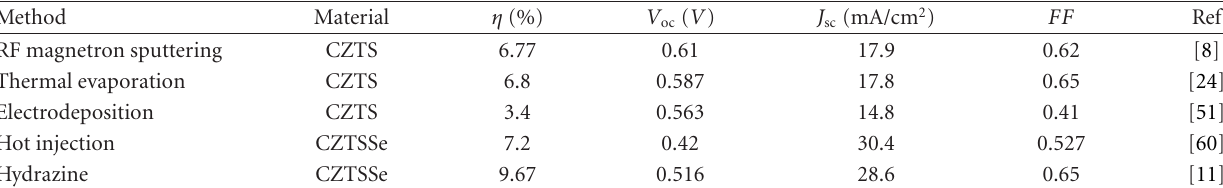
Table 1: Characteristic parameters of the current best e ffi ciency CZTS-based thin film solar cells with light absorber made by various